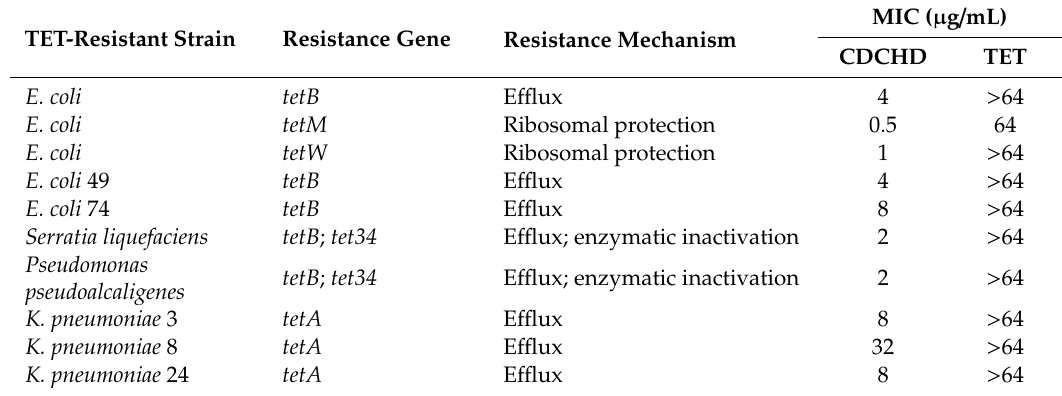
Table 3. Minimal inhibitory concentrations (MICs) of CDCHD and tetracycline (TET) against strains carrying di ff erent tetracycline resistance